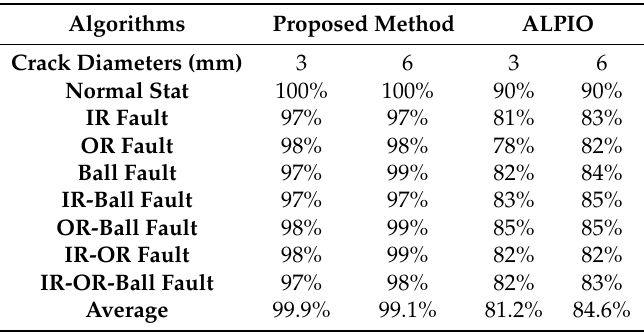
Table 5. Fault diagnosis results of dataset 4 using the proposed method and ARX-Laguerre proportional integral observation (ALPIO) when the torque speed is 500